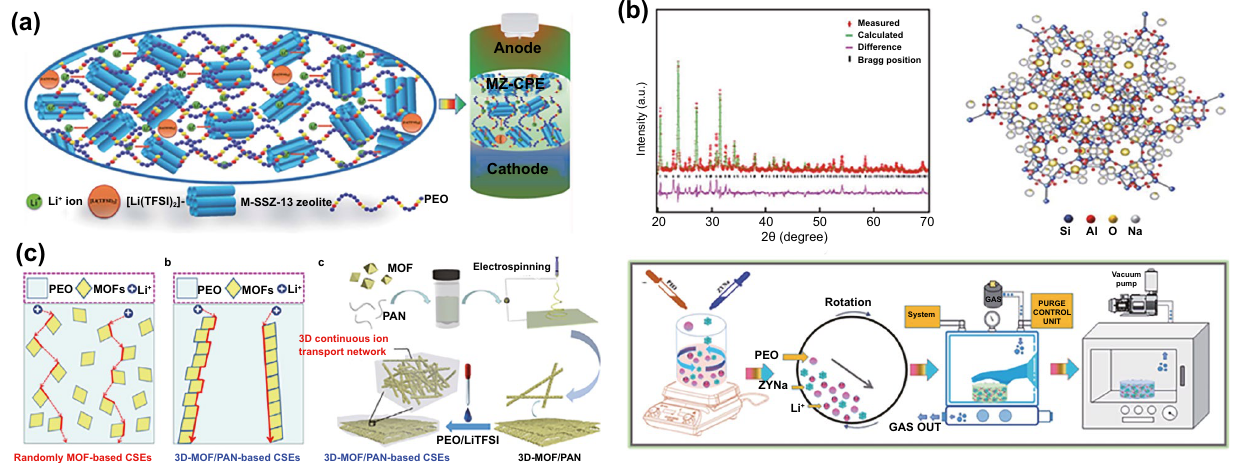
Randomly MOF-based CSEs 3D-MOF/PAN-based CSEs 3D-MOF/PAN-based